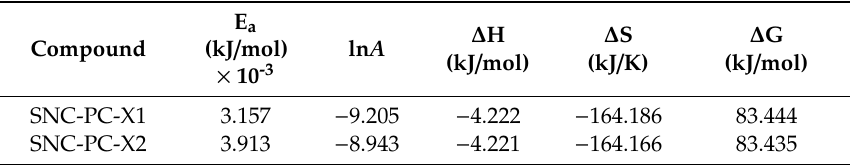
Table 2. Kinetic and thermodynamic parameters of SNC-PC-X1 and SNC-PC-X2 at the decomposition range of 200–270 °C.